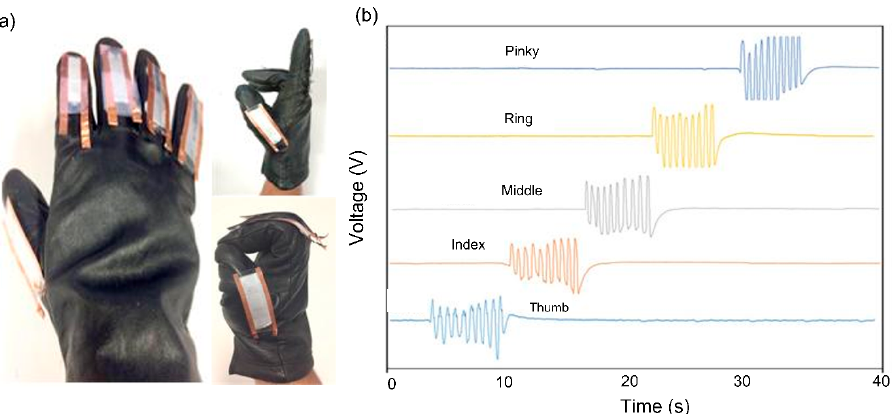
Figure 7. Flexible PVDF electrospun strain sensors for human-motion detection ( a ) photograph of five individual sensors mounted on a smart glove. The states of bending and stretching the glove fingers are also shown; ( b ) sensor output as a function of time for five independent strain sensors when each sensor move at frequency of about 1 Hz.